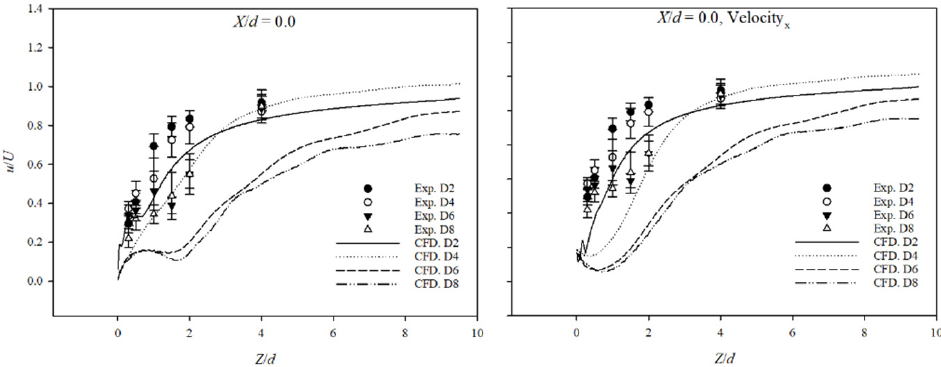
Figure 6. The normalized velocity profiles obtained by measurements and numerical analysis results.